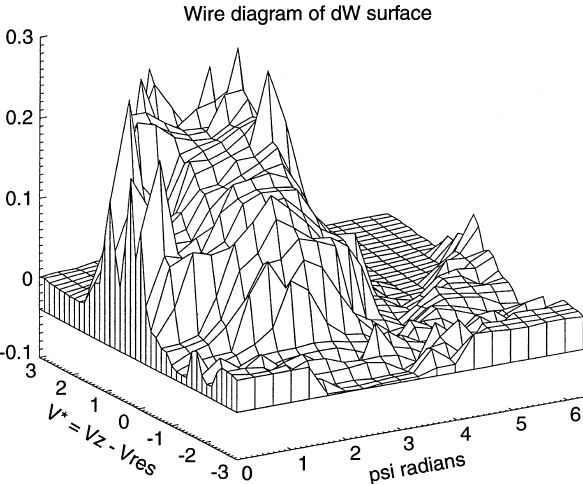
Fig. 8. Case A. Plot of integrated energy change D W in w = V (cid:3) space at z = 0. D W is in dimensionless units. The plot is presented as an IDL wire diagram and shows the dominance of stably trapped particles